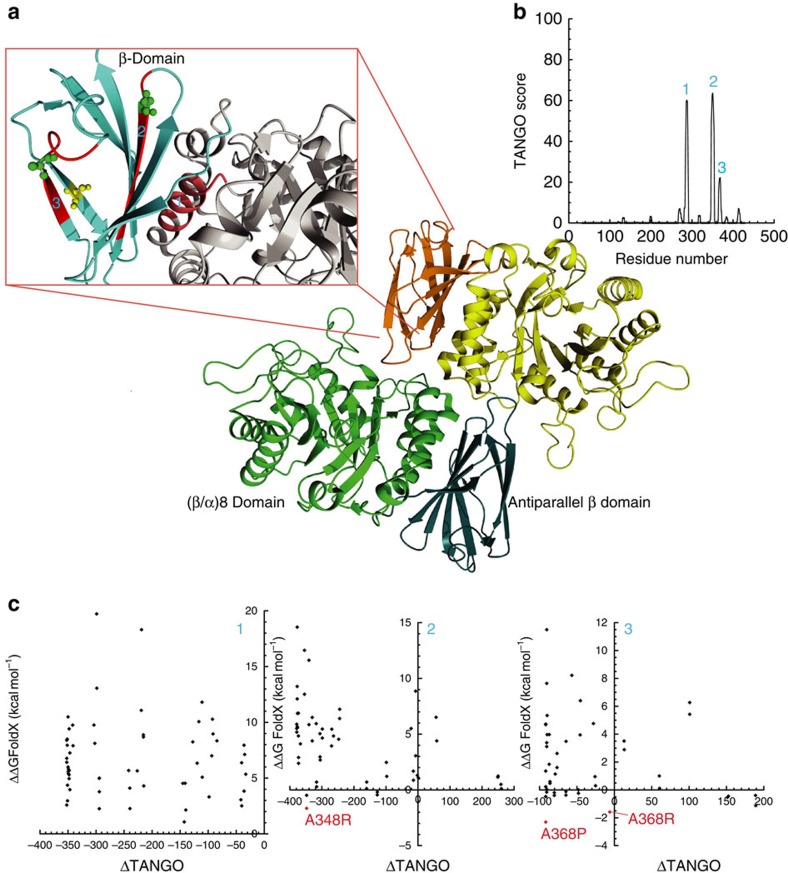
Structure and aggregation propensity of human WT α-Gal.(a) Human α-Gal is a homodimer (PDB 3GXP)54 in which each monomer contains a (β/α)8 domain (central part, yellow and green), where the active site is located and an antiparallel β-domain (central part, orange and blue). The structure was visualized with YASARA (ref. 53). (b) The intrinsic aggregation propensity of the α-Gal sequence as predicted by the TANGO algorithm reveals three strongly aggregation-prone regions: (1) M284ALWAIMA291; (2) L347AWAVAMI355; and (3) Y365TIAVAS371. The regions predicted by TANGO were indicated in the structure with numbers 1, 2 and 3 and were coloured in red (Fig. 1a). (c) Scatter plots representing the results of computational gatekeeper scans for each of the aggregation prone regions of α-Gal (ΔΔG FoldX versus ΔTANGO). For the TANGO region 2 mutation A348R could be identified (green amino acid residue in Fig. 1a), whereas for the TANGO region 3 mutations A368R and A368P (green amino acid residue in Fig. 1a) were identified.